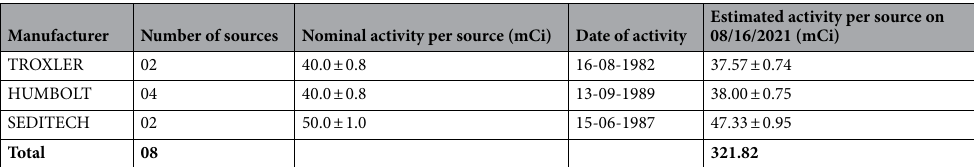
Table 1. List of disused sealed radioactive sources of 241 Am/Be considered for one P60 capsule and projected for the dismantling operation and long-term storage activity. The estimated activities were evaluated using the datasheet from the manufacturers, that is the radioactive decay law.